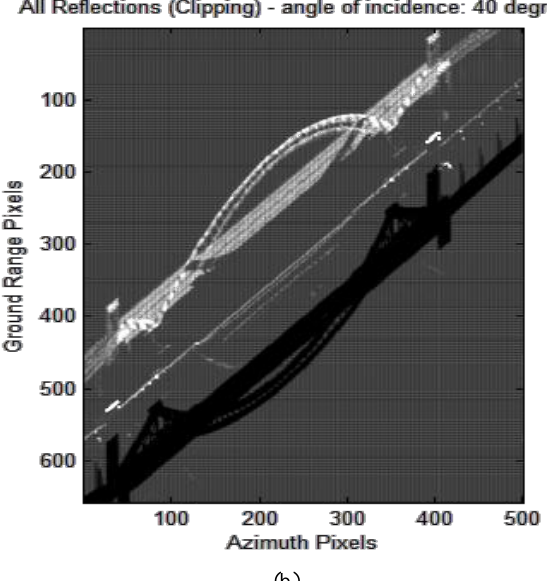
Figure 3.RaySAR simulated reflectivity maps (a) Ascending track (b) Descending